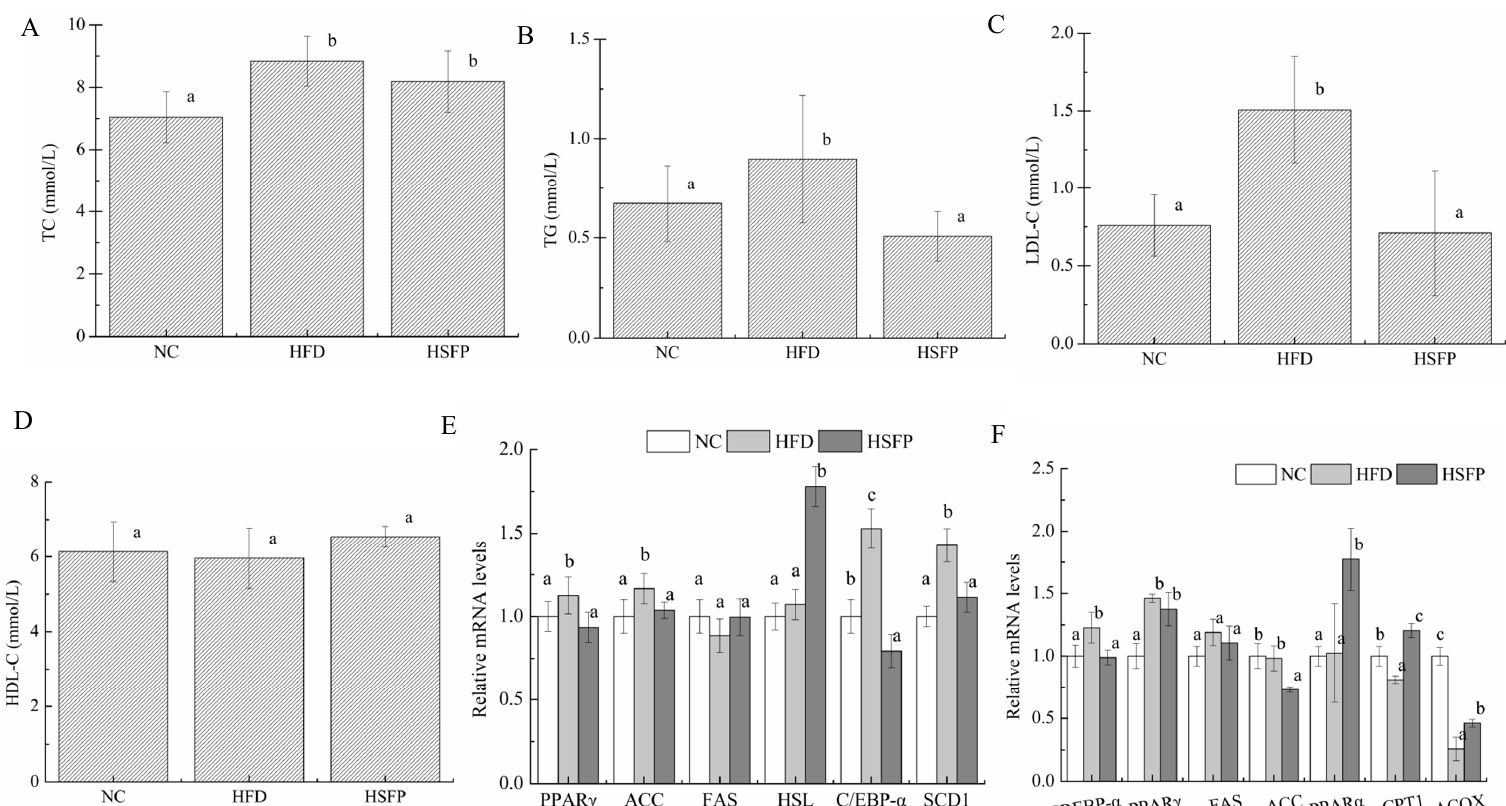
Figure 3. Seabuckthorn freeze-dried powder regulated lipid metabolism. ( A – D ) were serum lipid indexes, including total cholesterol (TC), triglyceride (TG), low-density lipoprotein cholesterol (LDL-C), and high-density lipoprotein cholesterol (HDL-C), and the expression levels of genes related to lipid synthesis and oxidation of the epididymal white adipose tissue ( E ) and liver ( F ), including peroxisome proliferator-activated receptor- γ (PPAR- γ ), acety1-CoA carboxylase (ACC), fatty acid syntheses (FAS), sterol regulatory element-bingding protein-1c (SREBP-1c), peroxisome proliferator-activated receptor- α (PPAR- α ), stearoyl-CoA desaturase 1 (SCD1), CCAAT / enhancer-binding protein alpha (C / EBP- α ), hormone-sensitive triglyceride lipase (HSL), carnitine palmitoyl transferase-1 (CPT-1), peroxisomal acyl coenzyme a oxidase (ACOX). All data are shown as means ± SD. Graph bars with di ff erent letters on the top correspond to statistically significant results ( p < 0.05) based on one-way ANOVA analysis followed by Duncan’s multiple range